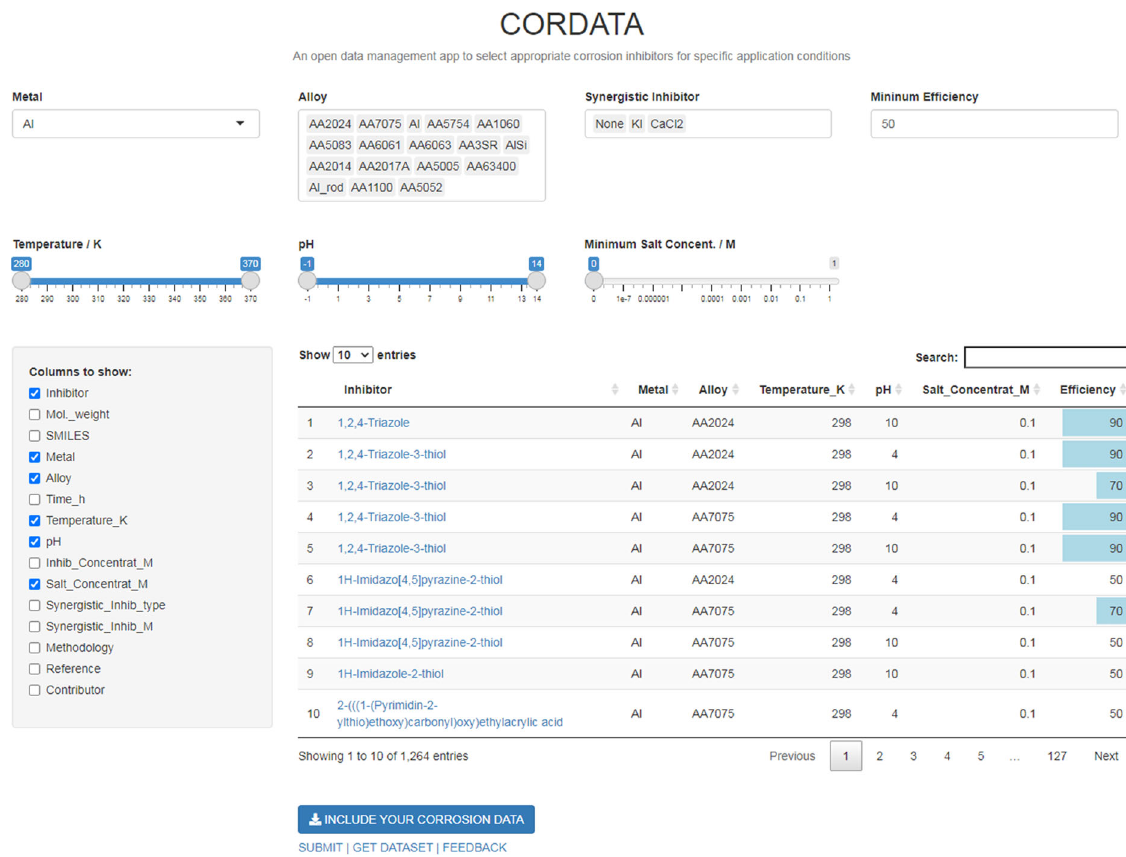
Fig. 1 Graphical user interface (GUI) of the CORDATA web application. The CORDATA GUI (https://datacor.shinyapps.io/cordata/) includes digital features to search and select the data, according to intended application conditions of the corrosion inhibitors, as well as the main table with corrosion inhibition ef fi ciencies and corresponding measurement properties.